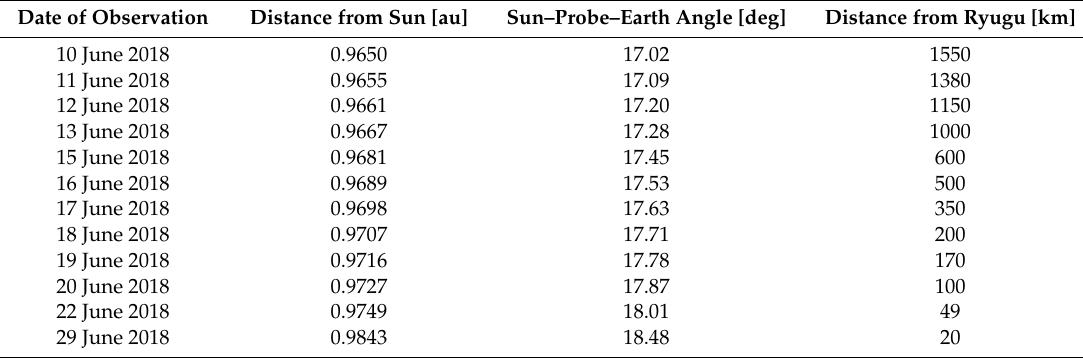
Table 2. Daily observations of asteroid Ryugu by TIR during the Approach